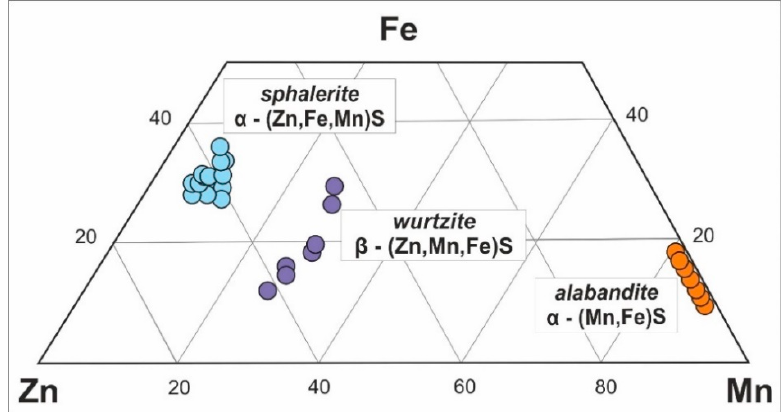
Figure 15. Triangular diagram in terms of atomic proportions (%) Zn, Fe, and Mn, showing the variation in wurtzite (n = 7), sphalerite (n = 17), and alabandite (n = 25) compositions from the Kochumdek marbles. Based on data from Table 6. Crystal system: α = isometric, β = hexagonal, n = number of analyses.